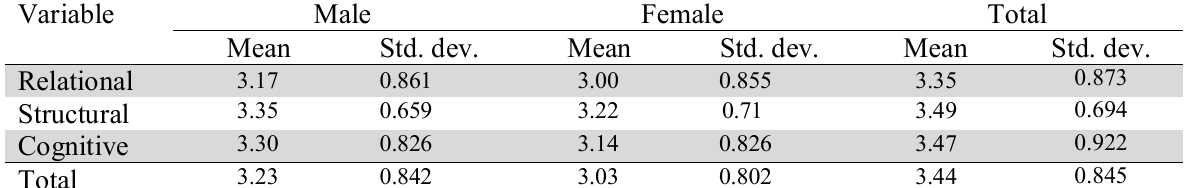
The summary of mean and standard deviation of gender in terms of social capital and gender Variable